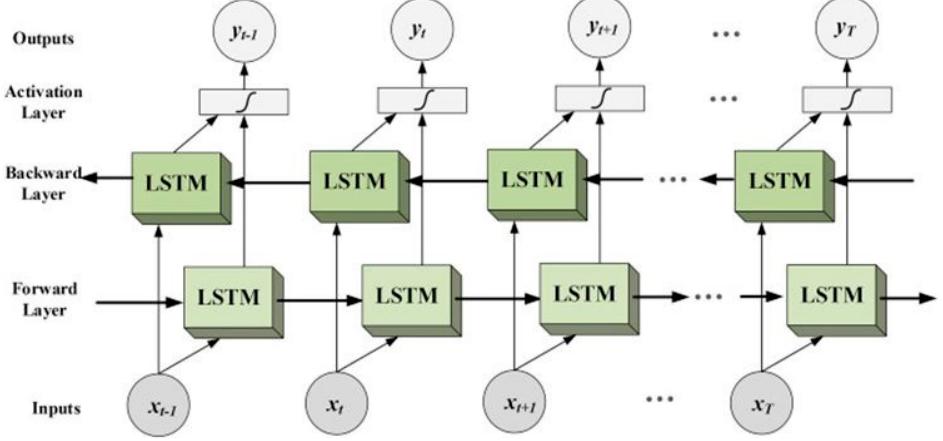
Figure A5. The basic structure of Bi-LSTM.